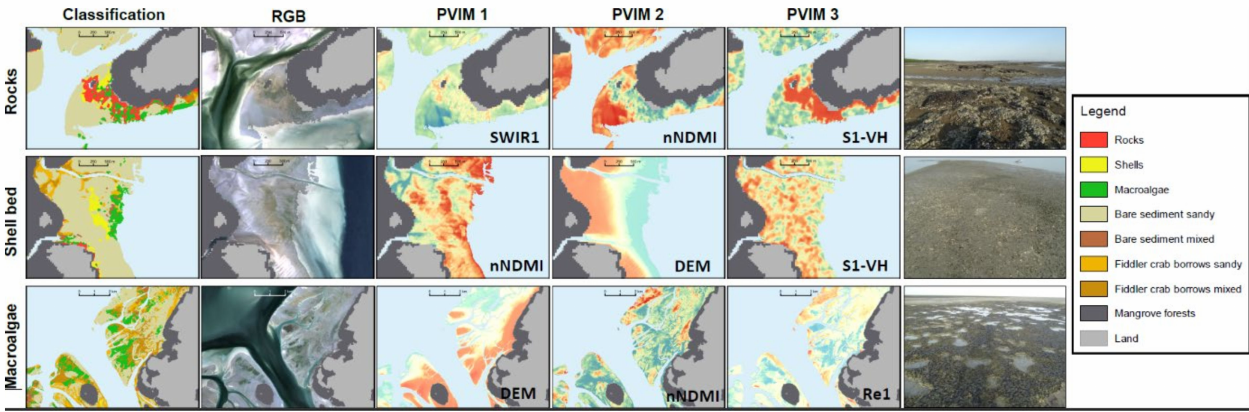
Figure 4. Map of the distribution of seven intertidal habitat types of the Bijag ó s Archipelago, generated with the final random forest model (14 predictors).